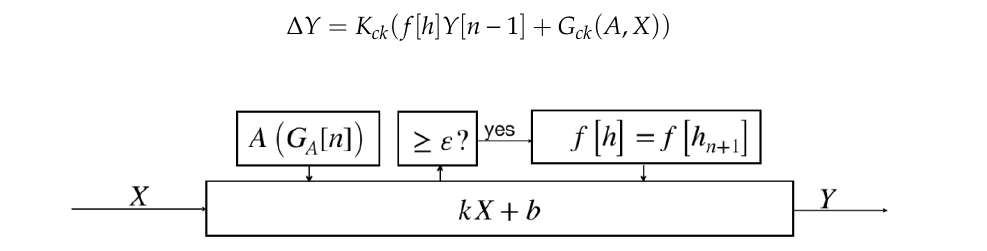
Figure 11. Calculation of calculation on frequency constancy intervals on the frequency constancy intervals.